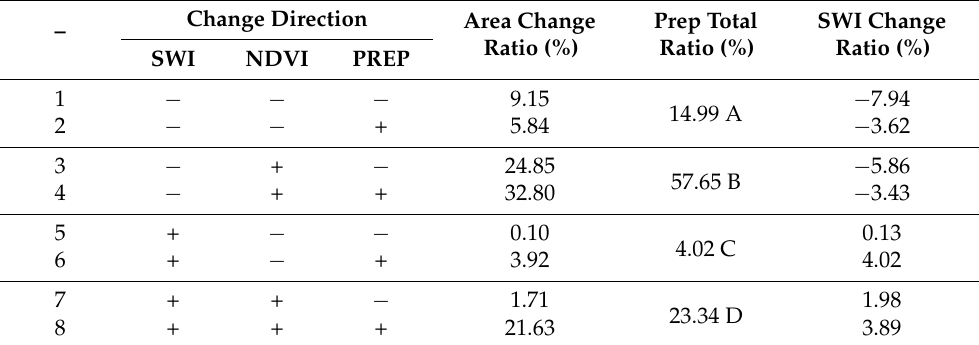
Table 4. The changes of precipitation in the 4 combinations of NDVI-SWI